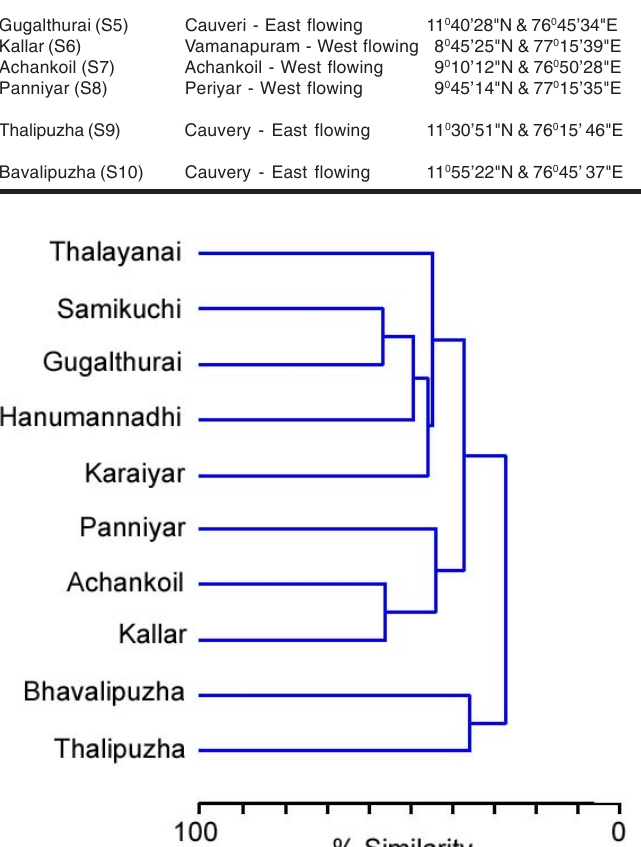
Figure 2. Dendrograms resulting from Bray-Curtis similarities of species abundance data of study streams. [S1-Samikuchi; S2-Thalayanai; S3-Karaiyar; S4-Hanumannadhi; S5-Gogalthurai; S6-Kallar; S7-Achankoil; S8-Panniyar; S9-Thalipuzha; S10- Bavalipuzha.]